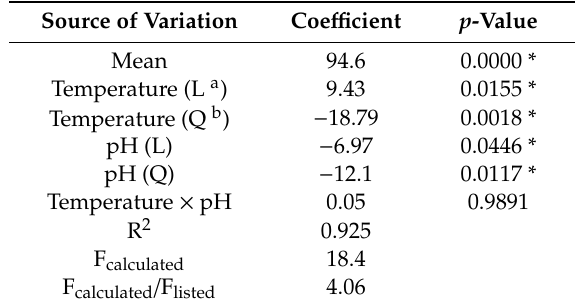
Table 6. Coe ffi cient values (for coded variables) and statistical analysis for β -mannanase.